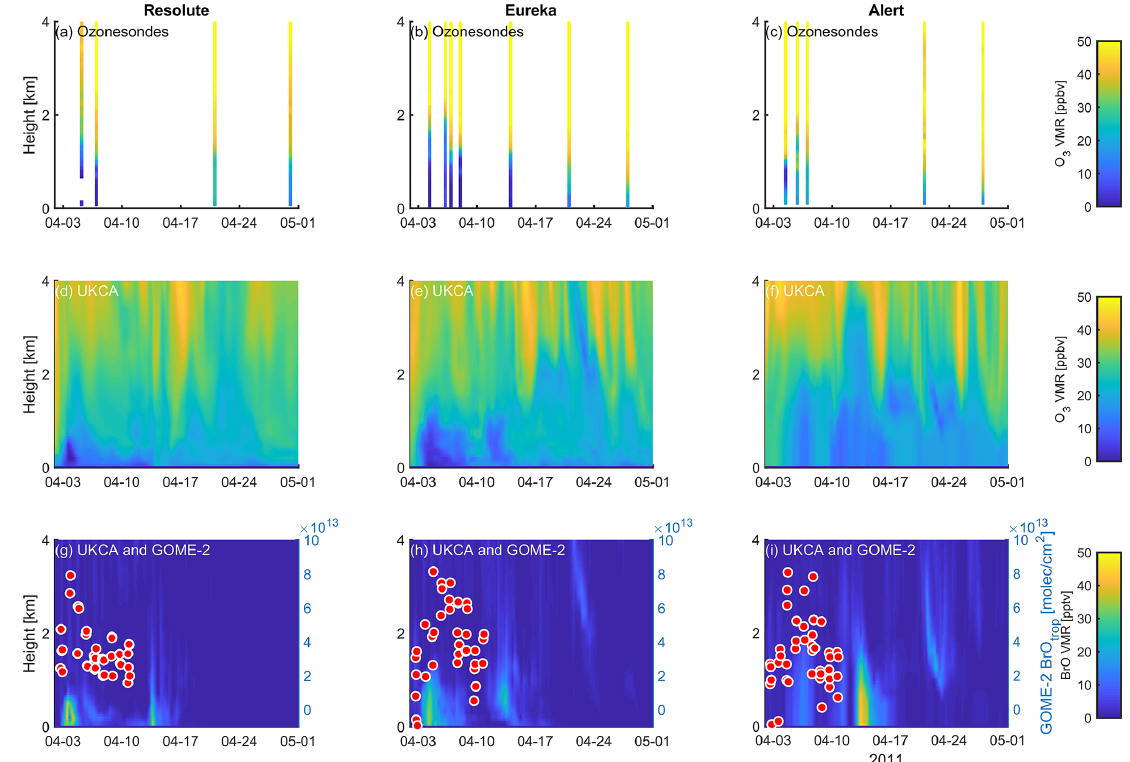
Figure 12. Profile of ozone-sonde (0–4km) at Resolute (a) , Eureka (b) , and Alert (c) during April 2011. UKCA_control ozone profiles (d–f) and BrO profiles (g–i) are also plotted. GOME-2 overpass data (tropospheric-column BrO) of the period 1–10 April 2011 are also plotted in (g) – (i) and detailed in Fig.